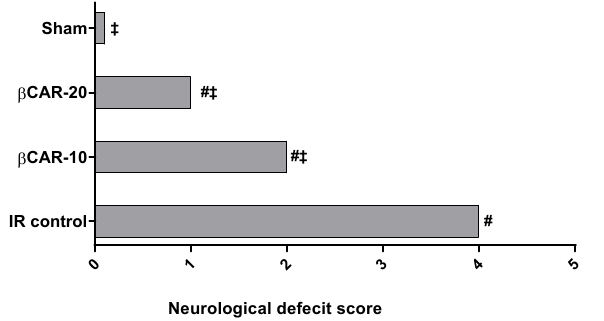
Figure 1. Neurological deficit scores 24 h after induction of cerebral I/R. #, ‡ denotes significant difference at p ≤ 0.05 vs. the sham and I/R control group, respectively, ( n = 12).